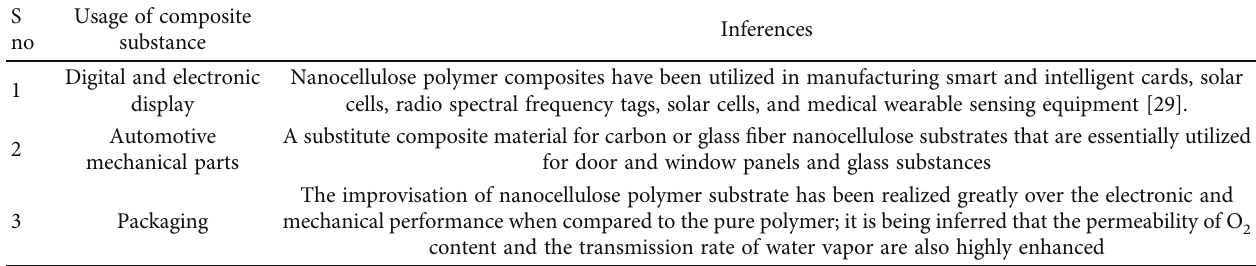
Table 3: Applications on nanocellulose polymer substrates, illustrating the electronic and mechanical